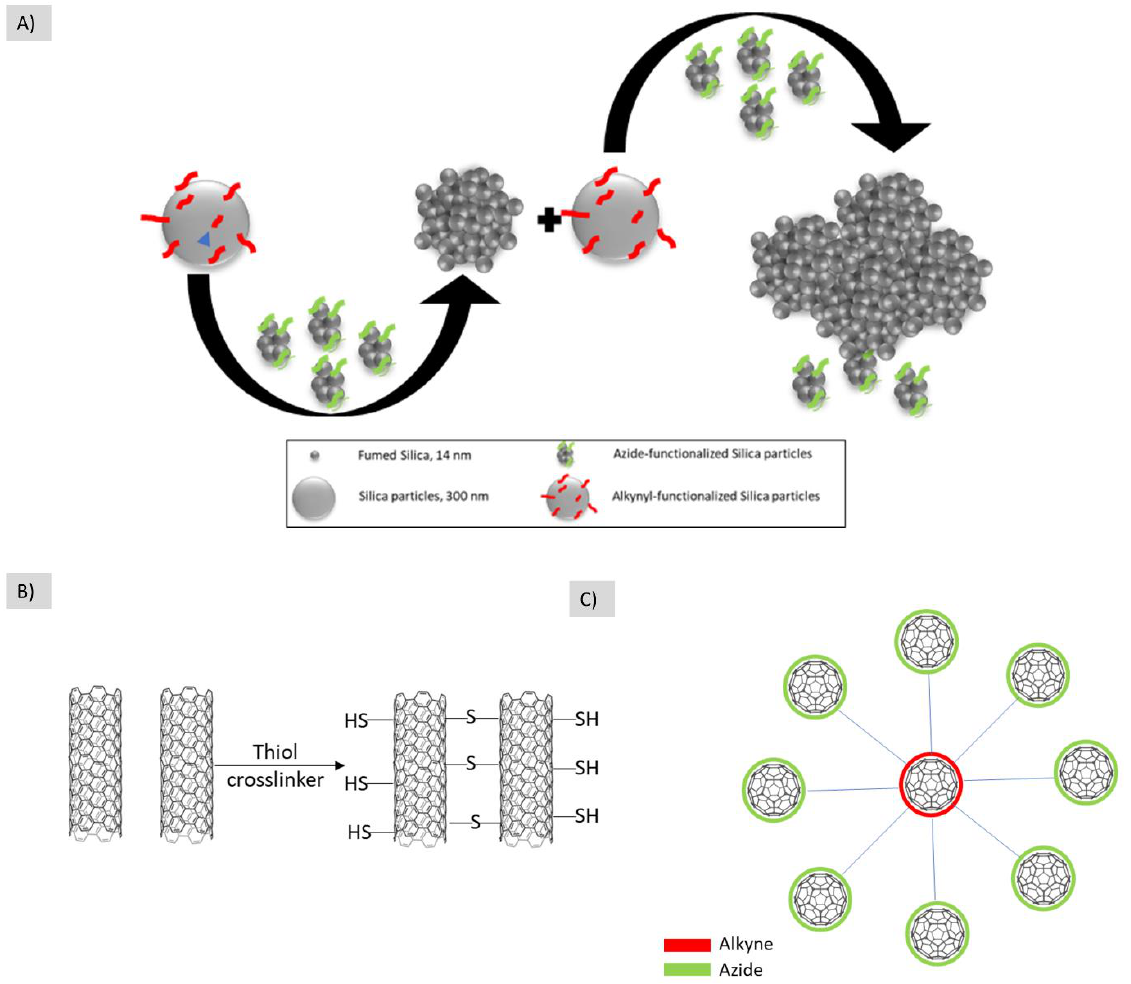
Figure 9. Different examples for the use of hard/hard nanobuilding blocks for building hierarchical structures. ( A ) Azide-funtionalized fumed silica is reacted with alkyl-functionalized silica particles to form hierarchical structures, ( B ) nanotubes are assembled using thiol crosslinkers after reacting with the ene in the nanotube structure, ( C ) the core fullerene is functionalized with azide while the shell ones are functionalized with alkyne to form this hierarchical structure. The illustrations are based on the work conducted by [53 – 55] , respectively.